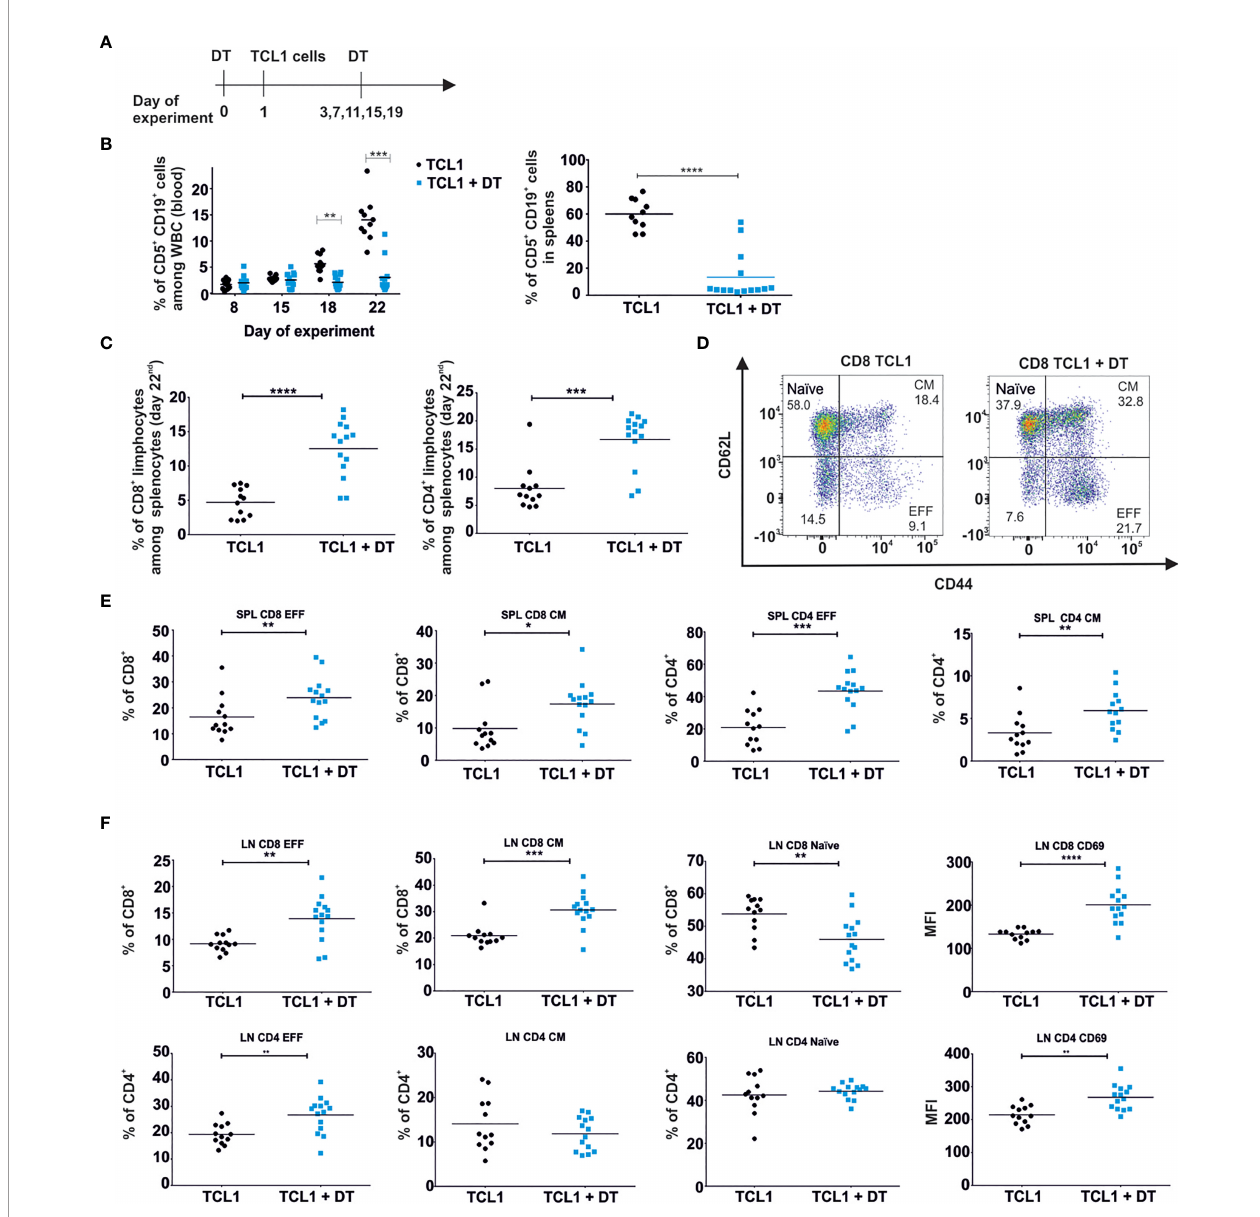
FIGURE 1 | Depletion of Tregs diminishes the progression of leukemia in DEREG mice and affects the relative frequency of conventional T cell subpopulations. (A) The graph presenting a scheme of the experiment. Tregs were depleted with DT and on the next day mice were injected with TCL1 CD19 + leukemic cells. The depletion of Tregs (DT administration) was repeated every 4 days. (B) The percentage of leukemic cells (CD5 + CD19 + ) among all white blood cells (WBC) assessed by fl ow cytometry in blood (at indicated time points of the experiment, left) and spleens (day 22 nd of experiment, right) of untreated (TCL1) and DT-treated (TCL1+DT) TCL1 leukemia-bearing mice. The graphs represent mean results from two independent experiments. Each dot represents an individual sample (mouse), n = 10-12, Mann-Whitney U test *p ≤ 0.05. (C) The Percentage of CD8 + (left) and CD4 + (right) T cells in spleens of untreated and DT-treated TCL1 leukemia-bearing mice. The graphs present mean results from two independent experiments. Each dot represents an individual sample (mouse), n = 12-14, Mann-Whitney U test ***p ≤ 0.001, ****p < 0.0001. (D – F) The percentage of CD4 + and CD8 + T cells with phenotype of naïve, effector (EFF) and central memory (CM) subpopulations according to the expression of CD44 and CD62L surface markers. Representative dot plots with a gating strategy (D) and the graphs present the results from spleens (SPL) (E) and lymph nodes (LN) (F) of untreated and DT-treated TCL1 leukemia-bearing mice. In (F) the graphs presenting the expression of CD69 surface marker on CD4 + and CD8 + T cells in LN are also shown. The data from two independent experiments are showing mean values. Each dot represents an individual sample (mouse), n = 12-14, Mann-Whitney U test *p ≤ 0.05, **p ≤ 0.01, ***p ≤ 0.001, ****p <